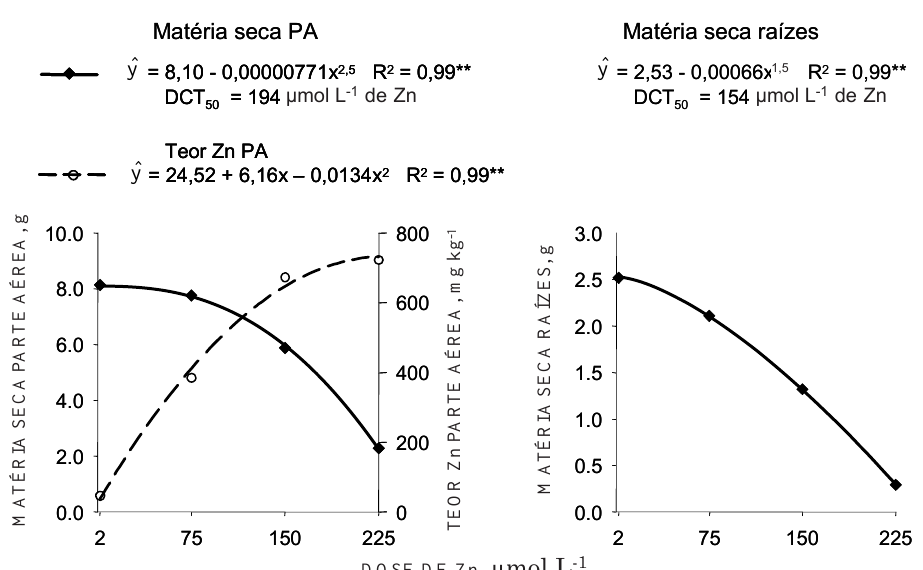
2 75 150 Figura 1. Matéria seca da parte aérea e de raízes e teores de Zn na parte aérea da Trema micrantha , considerando as doses de Zn em solução nutritiva (média dos pré-tratamentos de P e MA). DCT concentração de Zn na solução que inibe em 50 % a produção de matéria seca (** P ≤≤ ≤≤ ≤ 0,01).